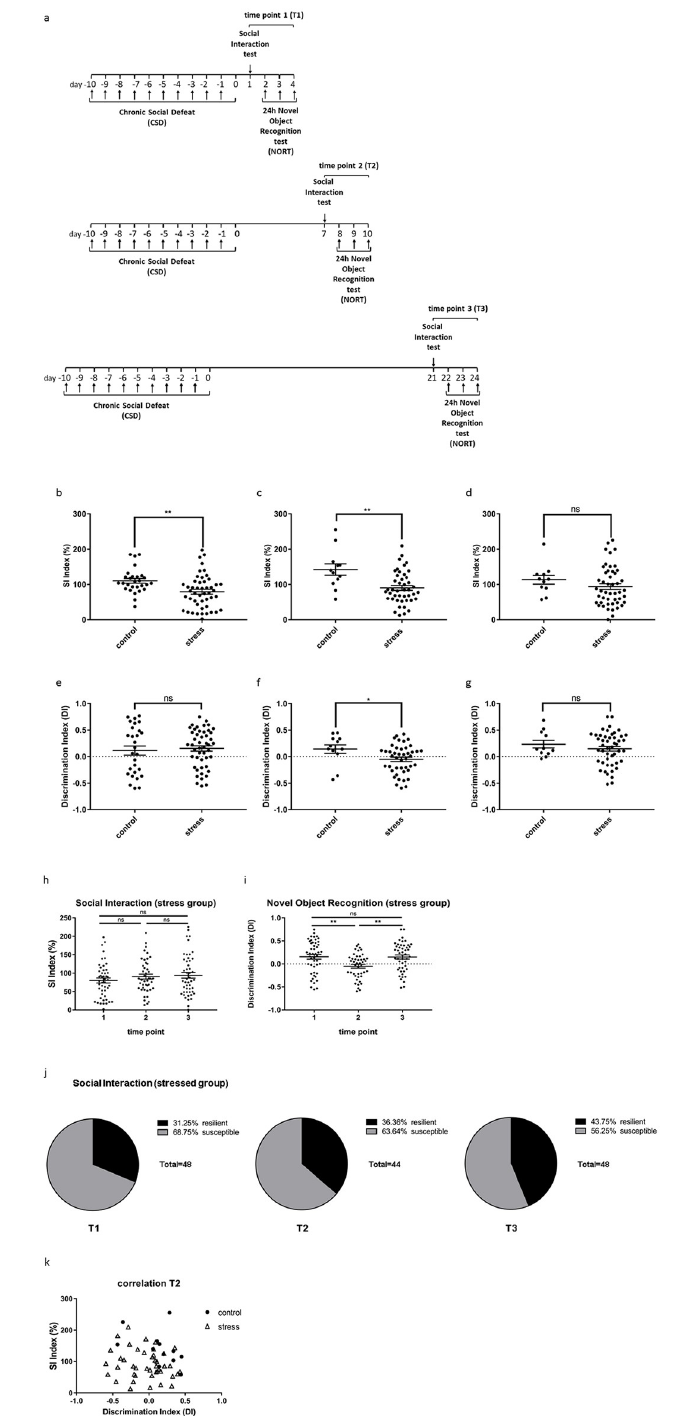
Fig 1. Animal behavior changes with time post exposure to CSD stress. (a) Experimental setup timeline. Within 11 days test mice were housed in sensory contact with a daily changed aggressor mouse. Each day they were exposed to fight for 15–25 seconds. Control mice were not exposed to fight, but housed equally. Each group was tested for social interaction and novel object recognition either 1–4 days (T1), 7–10 days (T2) or 21–24 days (T3) post CSD. (b-d) SI scores at T1, T2 or T3 of stressed and control mice. Social avoidance is clearly visible at T1 (p = 0.0020, Unpaired t test with Welch’s correction) and T2 (p = 0.0089, Unpaired t test with Welch’s correction). At T3 there is no significant